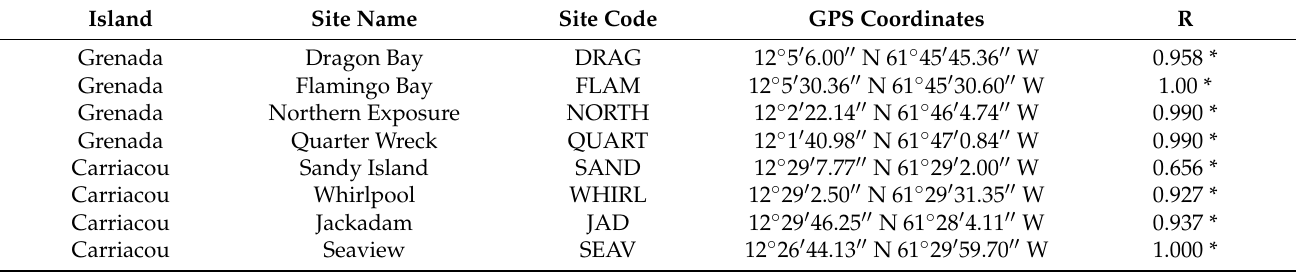
Table 1. Benthic survey site names, site code for figures, locations, GPS coordinates, and similarity of species assemblages at study sites between 2014 and 2017 with p -values. Sites with values closer to 0 have similar species assemblages, those with values closer to 1 have very different species assemblages. All results are based on 200 permutations.